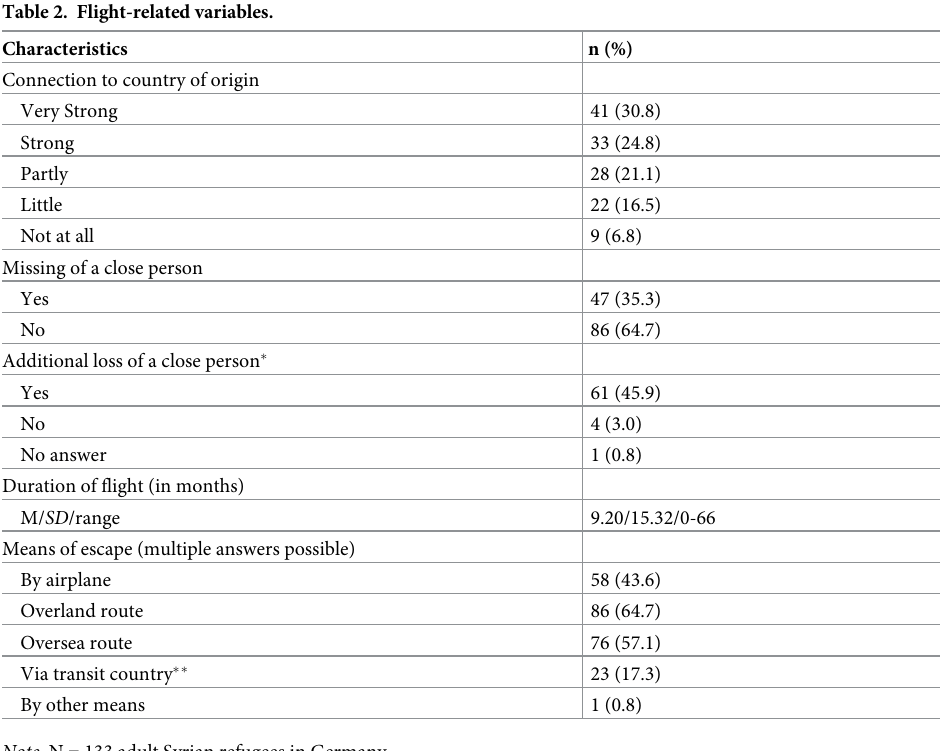
Table 2. Flight-related